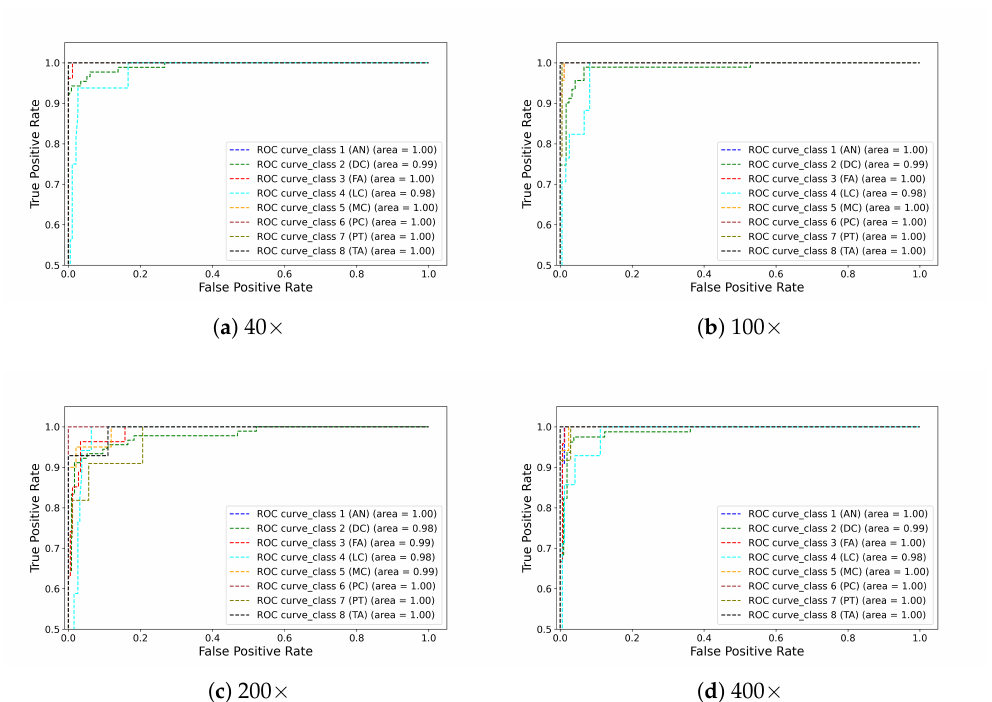
Figure 8. Illustration of the ROC curve of eight classes obtained through the proposed model on the test set. Note that ( a – d ) refer to the 40 × , 100 × , 200 × , and 400 × magnifications,